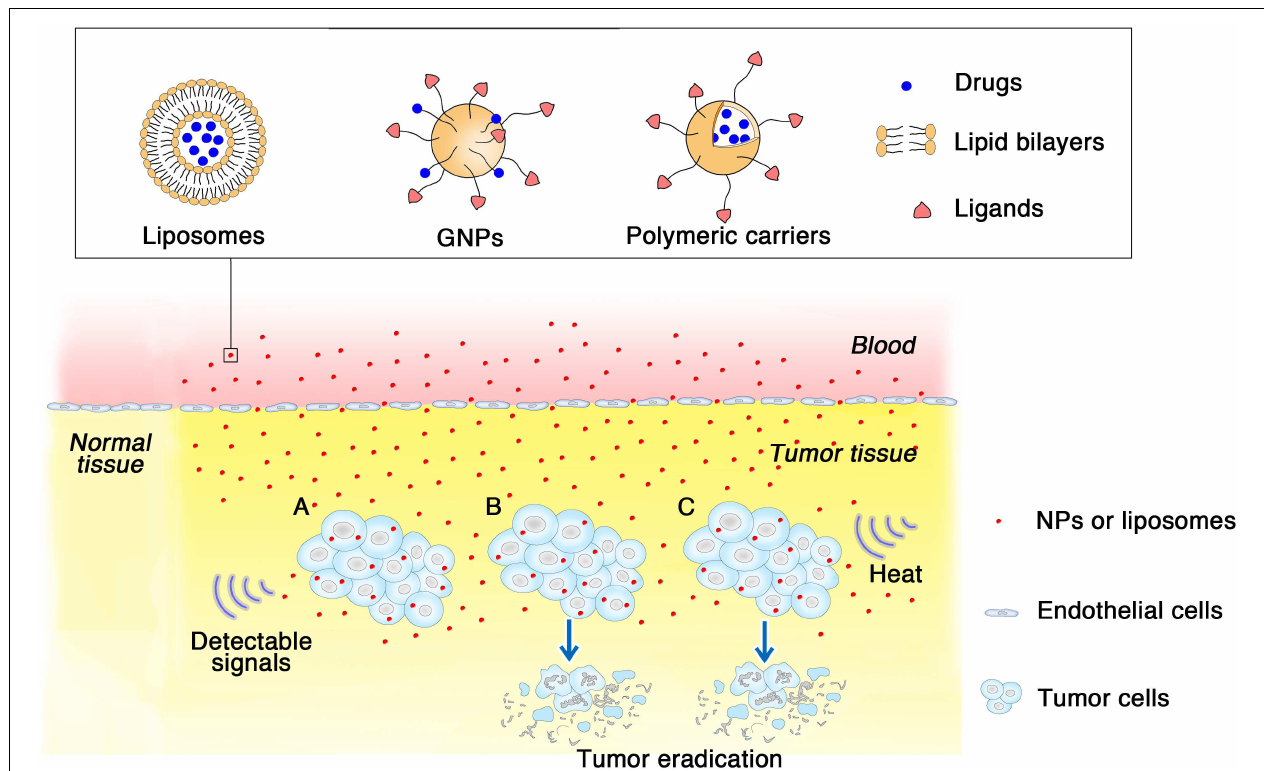
FIGURE 1 | How different kinds of NPs applied in urological cancer diagnosis and therapeutics. Three types of NPs are listed for examples, liposomes, GNPs and polymeric NPs. With specific ligands modified on the surface, NPs show specifia targeting to the tumor cells via EPR effect. (A) NPs as imaging agents gather around tumor tissues then send and amplify detectable signals which are received subsequently. (B) NPs loaded with cytotoxic drugs arrive at tumor tissue, and then lead to tumor eradication. (C) In hyperthermia therapy, NPs absorbing heat energy induce a high temperature, causing focal cell death and preserve the circumambient normal